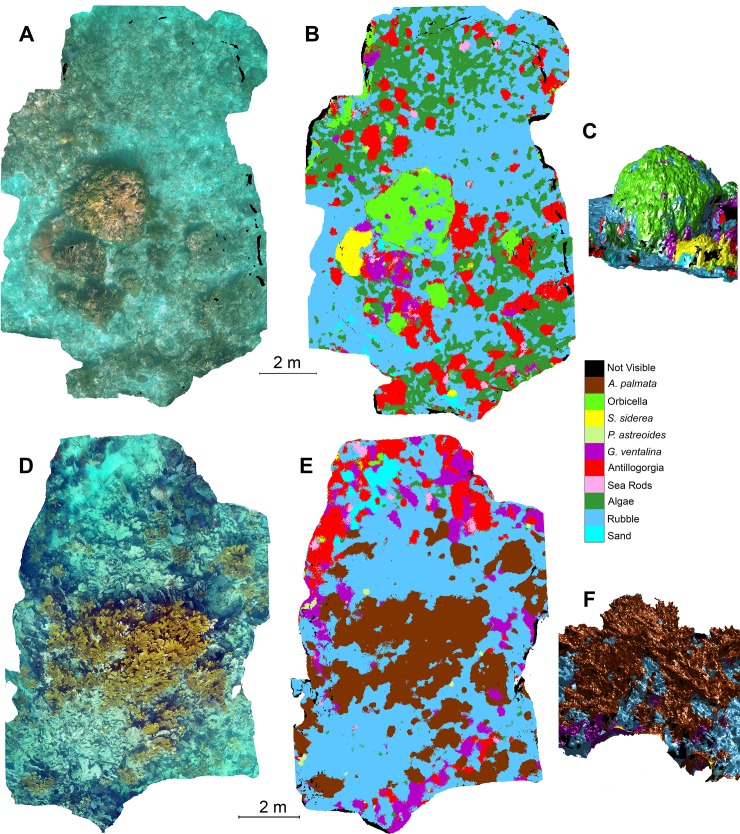
Sample texture-mapped and classified 3D reconstructions.A) Texture-mapped and B) classified reconstructions of a segment of
Little Grecian reef (LG1) viewed from overhead. C) Shows a side view of
the classified reconstruction with shading to highlight its
three-dimensional nature. D) Texture-mapped and E) classified
reconstructions of a portion of Horseshoe reef (H1). F) Shows a
side-view of the classified reconstruction. 3D reconstructions were
generated and texture-mapped from the original images using commercial
software (Agisoft Photoscan). The 3D reconstructions were then
classified using the nViewNet-8 neural network. This figure is best
viewed on a computer screen.